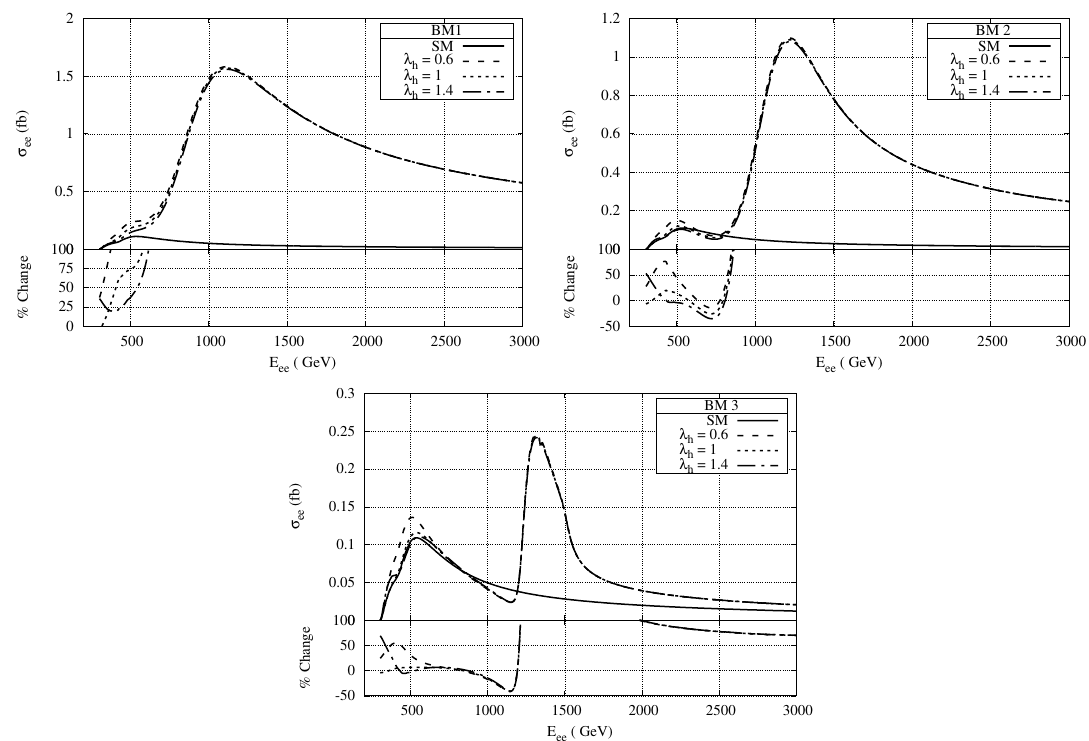
Figure 9 . e + e − → hh cross-section in the model with an additional heavy scalar H . The bench- mark points (BM) for the above results are given in table 5.